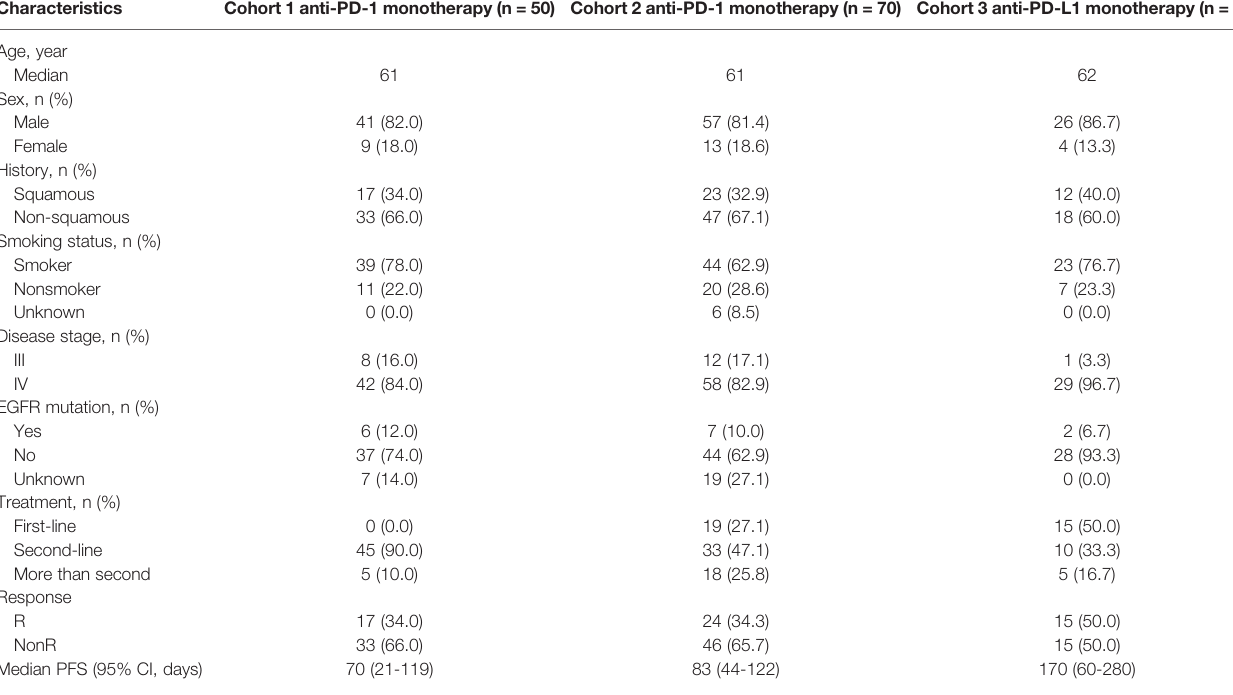
TABLE 1 | Clinical manifestations of advanced NSCLC patients receiving ICI